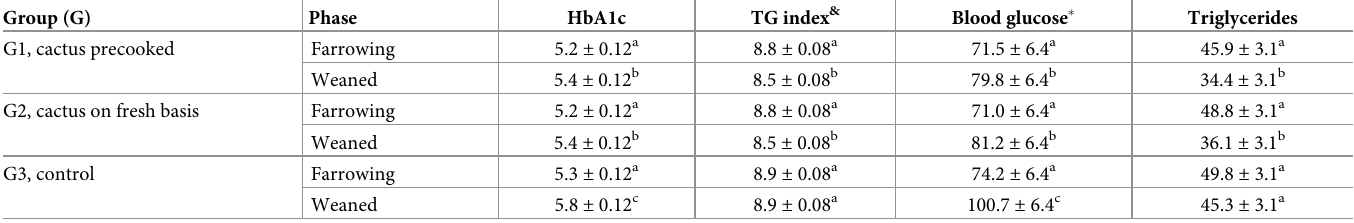
Table 5. Least squares mean ( ± SEM) for the mean values of HbA1c (%), triglyceride and glucose index (TG, Ln), preprandial blood glucose (mg/dL) and triglycer- ides (mg/dL) in the farrowing day and weaning day according to the group and phase. Group